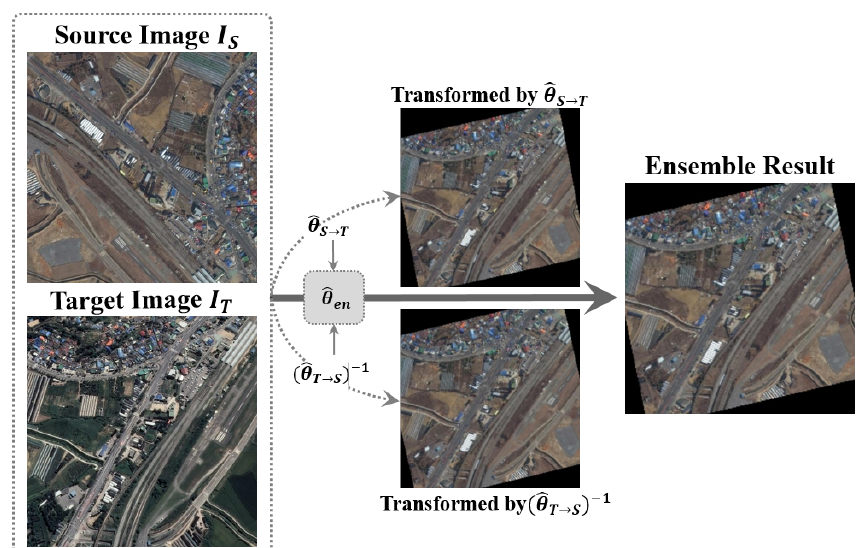
Figure 7. Ensemble process of affine parameters. The outcomes that correspond to the original pair are the transformation parameters ( ˆ θ S → T , ˆ θ T → S ) in two possible directions. Since the affine transformation is isomorphic, we can use the inverse of ˆ θ T → S to warp the source image to the target image. Therefore, the final transformation parameters are obtained by fusing these